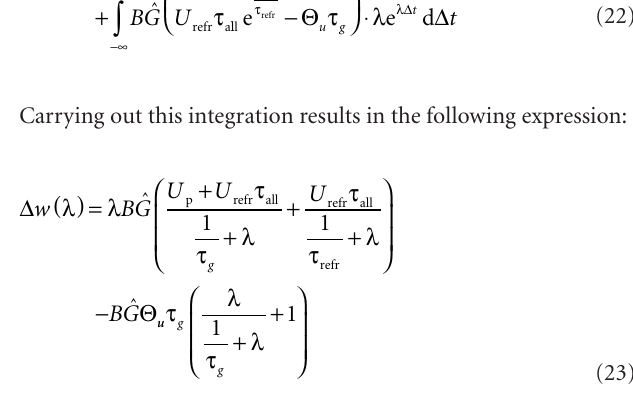
FigurE 5 | Plot of the analytical BCM expression of Eq. 23 for sweeps of different variables. The standard parameter set (Froemke 1 in Table 4 : Θ U = 151 mV·ms, U = − 5 mV) is always denoted by the broken line. (A) sweep of Θ p refr